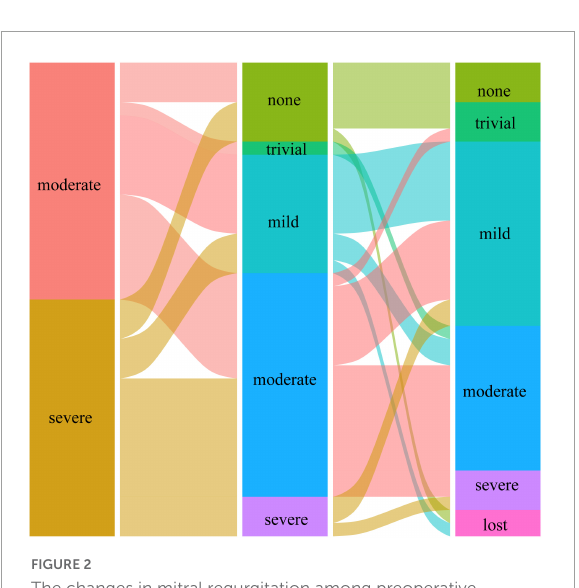
FIGURE1 The changes in mitral regurgitation among preoperative, postoperative, and last follow-up periods in group II.